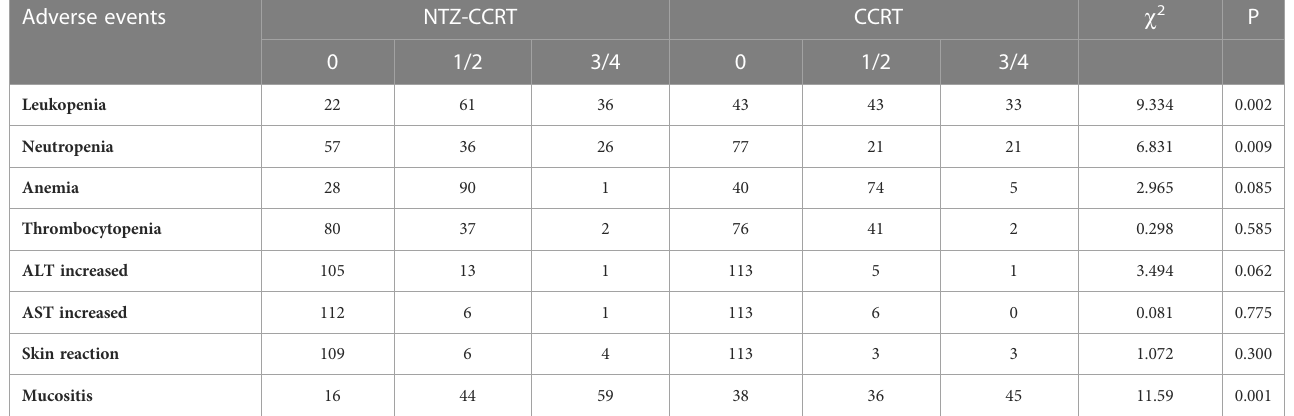
TABLE 4 Acute toxicities in the NPC